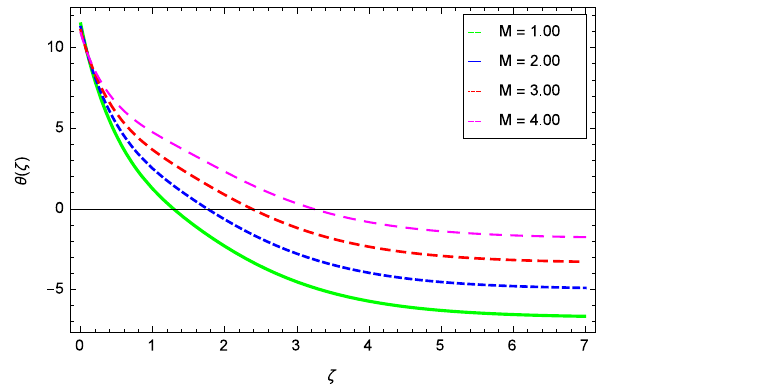
Figure 28. Effect of M on temperature θ(ζ) .